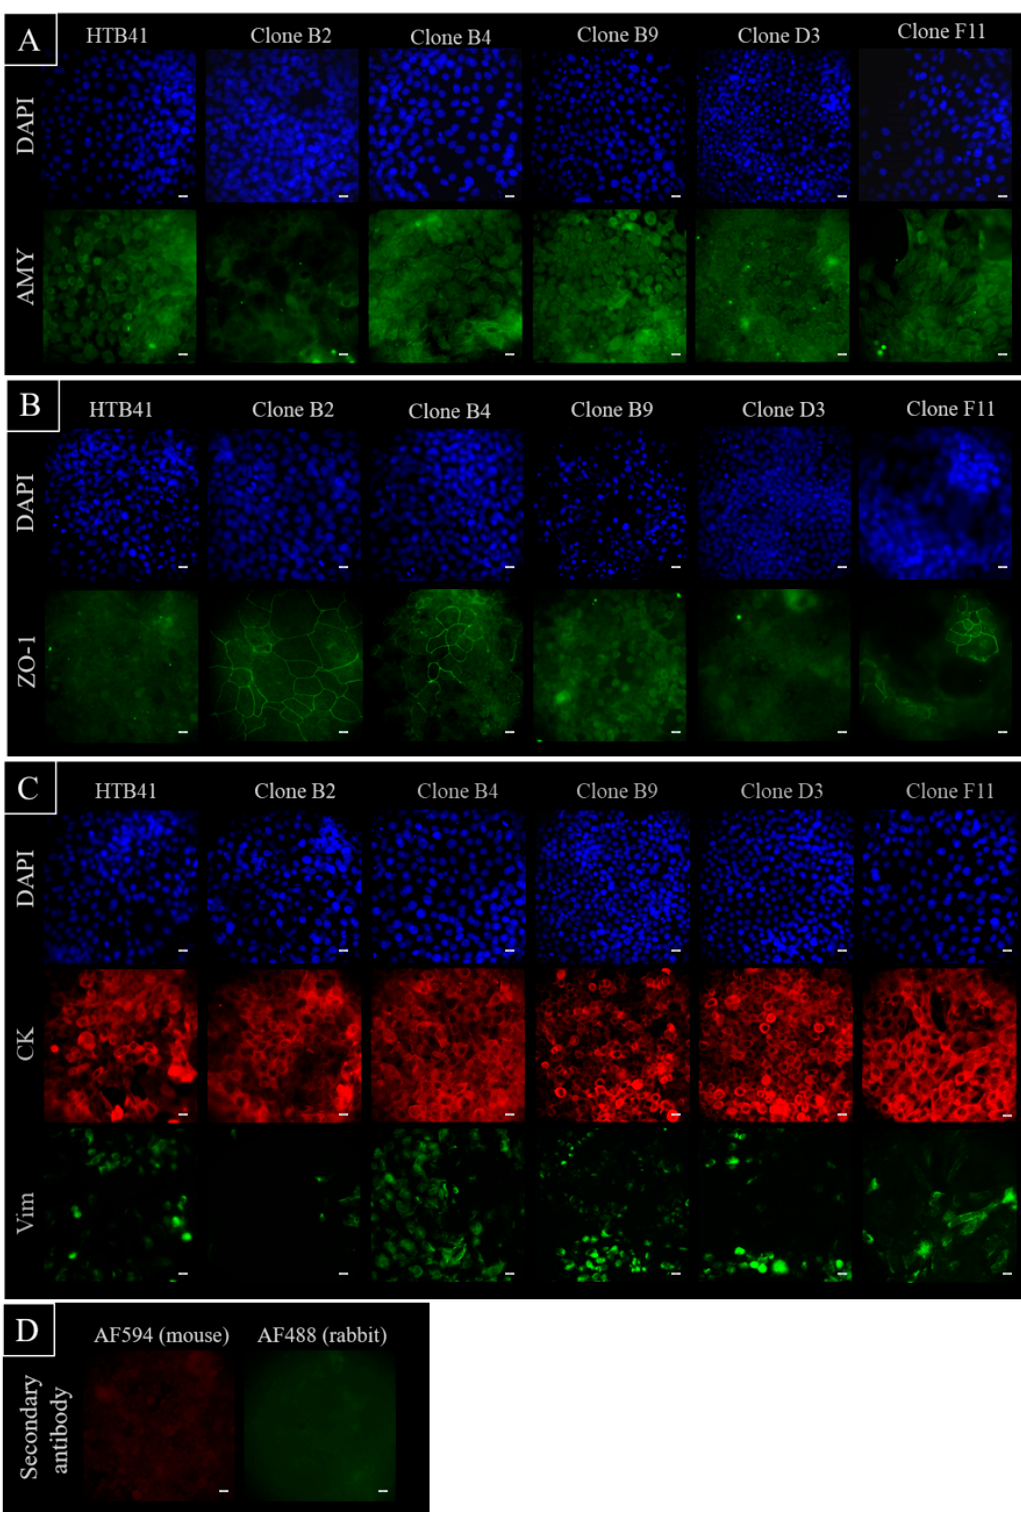
Figure 4. Immunofluorescence staining of parental HTB-41 cells and isolated clones B2, B4, B9, D3, and F11 seeded on microscopic slides for DAPI (blue, cell nuclei) and ( A ) α -amylase (AMY), ( B ) Zonula occudens-1 (ZO-1), ( C ) cytokeratin 5 / 8 (CK) and vimentin (Vim) expression and localization analysis shown at 40× magnification. ( D ) Images of stainings at 40× magnification of controls omitting primary antibodies captured at the same settings and exposure times as stainings shown in ( A – C ), each white scale bar accords to 20 µ